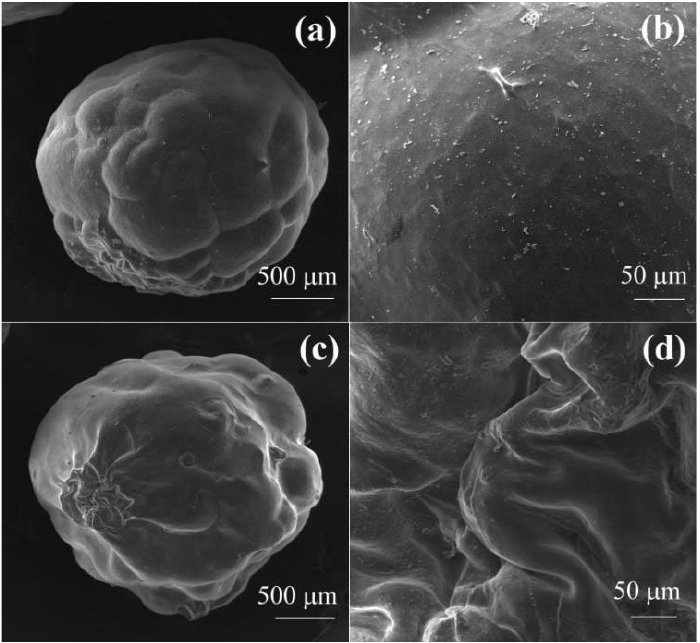
Figure 4. SEM images of SA hydrogel beads ( a , b ), Tan/SA ‐ 40% hydrogel beads ( c , d ) after heat treatment (T = 50 °C, t = 48 h, s = 200 rpm).